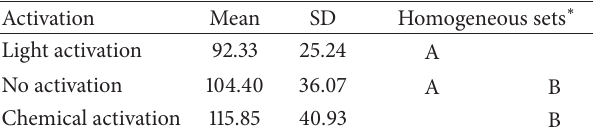
Table 3: Results of Tukey’s test for the activation